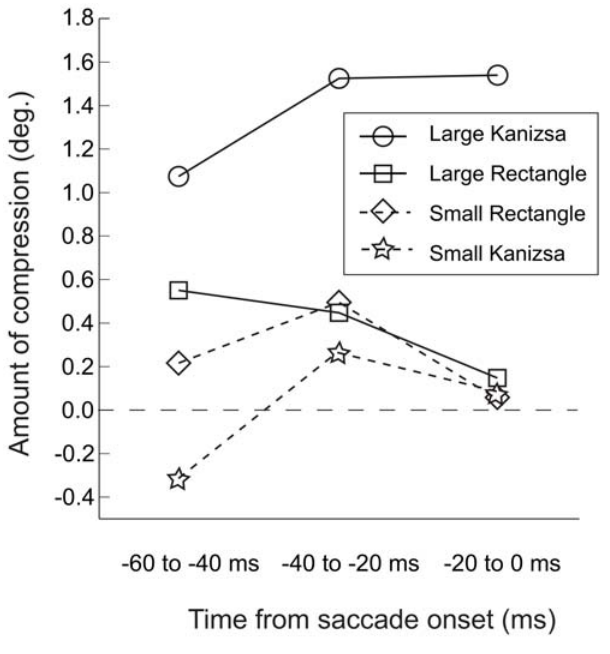
Figure 5. Experiment 1A: Mean amount of compression (Kanizsa-Rectangle) by figure onset time relative to saccade onset.